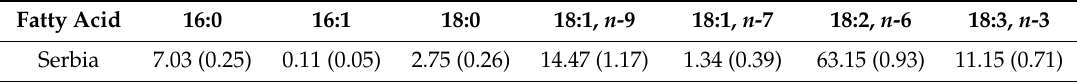
Table 2. Fatty acid composition of composite samples from di ff erent markets in Serbia.